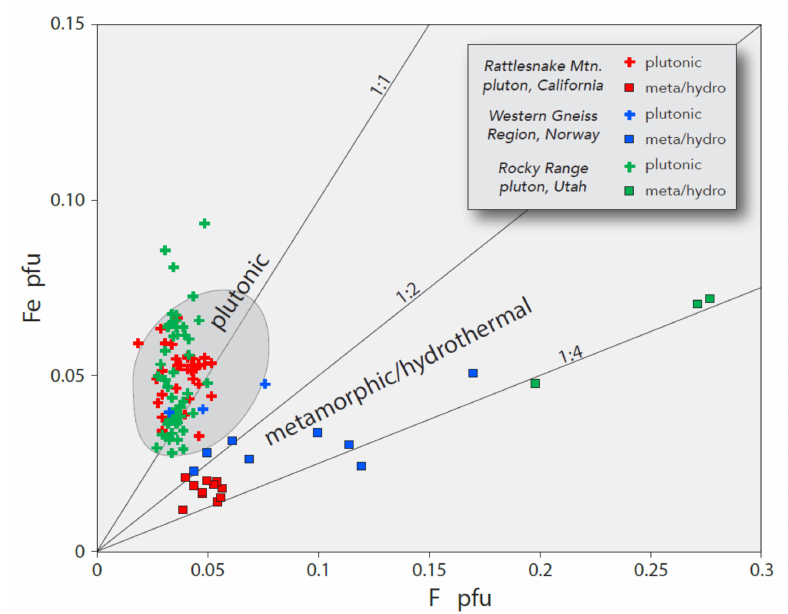
Figure 15. Fe versus F for plutonic titanite and their metamorphic or hydrothermal overgrowths. Data sources are Rattlesnake Mountain pluton, California (this paper); Western Gneiss Region, Norway [109], and Rocky Range pluton, Utah (this paper). Shaded area is for 90% of other plutonic titanite in our